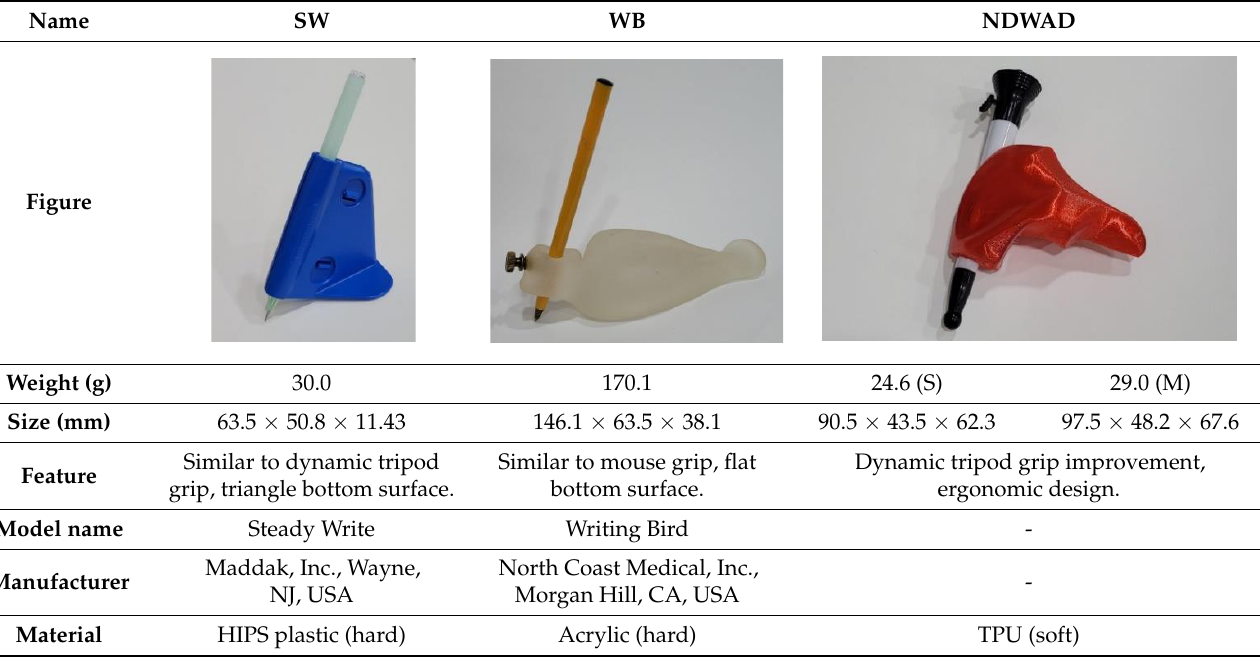
Table 3. Experimental tool information.